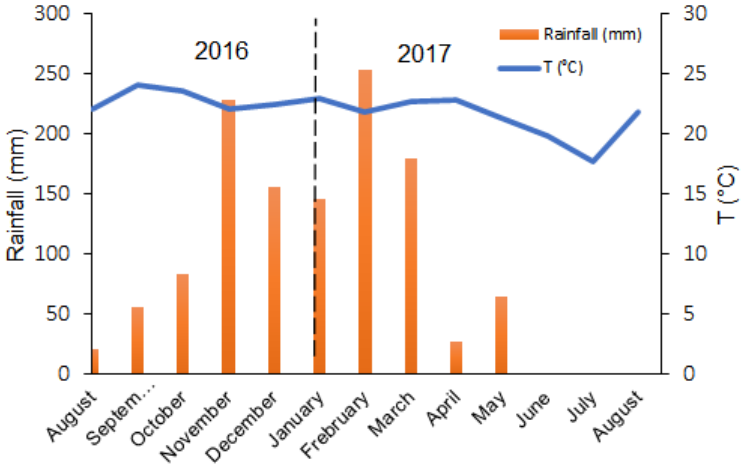
Figure 2. Precipitation and air temperature records for the study time. Data source: Brazilian National Institute of Meteorology (INMET).